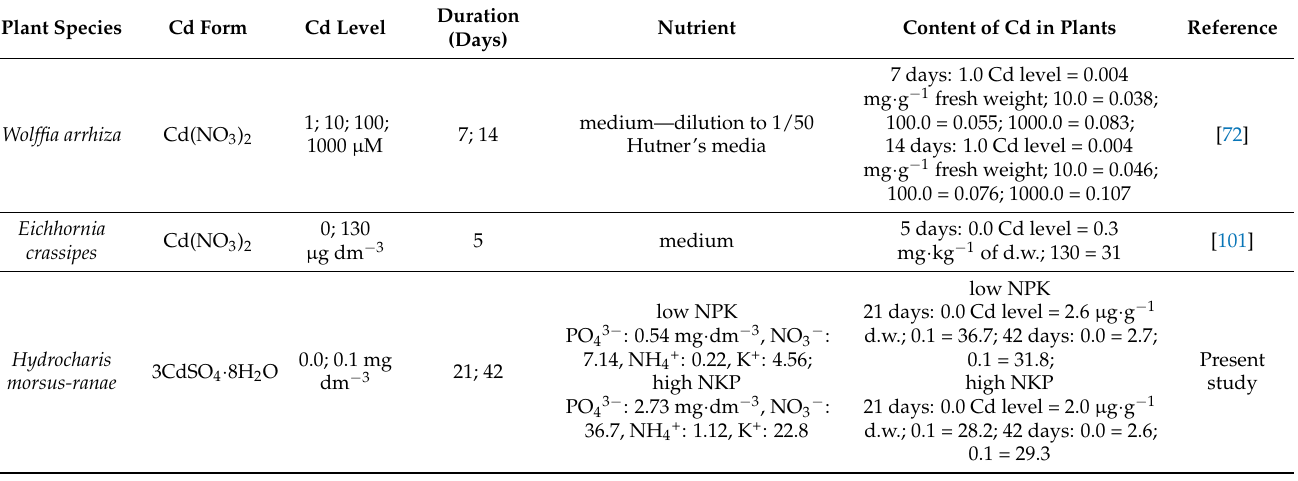
Table 13. Cadmium accumulation potential of various pleustofity.